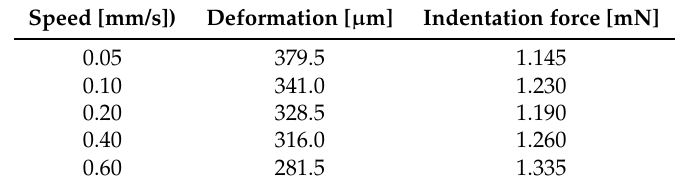
Table 1. Experimental results: injection speed, deformation, and indentation force.